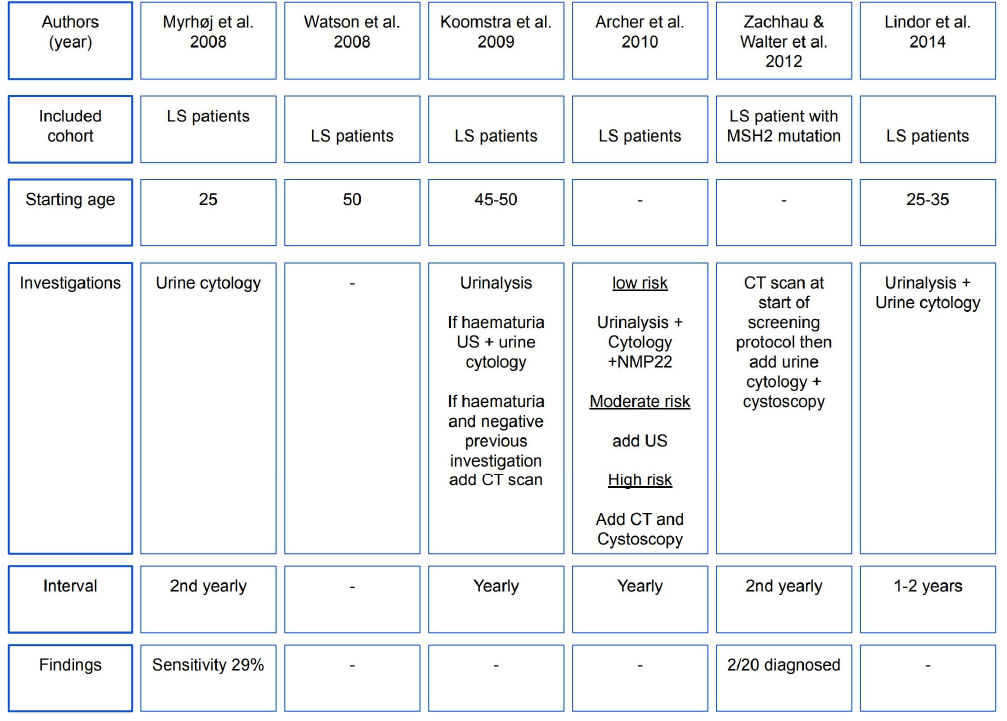
Figure 3. Flow chart summarising screening strategies for the detection of upper tract urothelial carcinoma among individuals with Lynch syndrome [35,81–85]. Adapted from the European Association of Urology—Young Academic Urologists and Global Society of Rare Genitourinary Tumours [28].